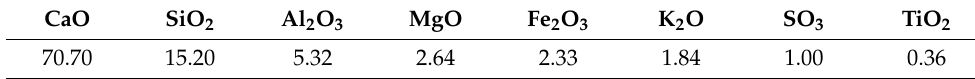
Table 1. The main chemical components of hydraulic lime (%).